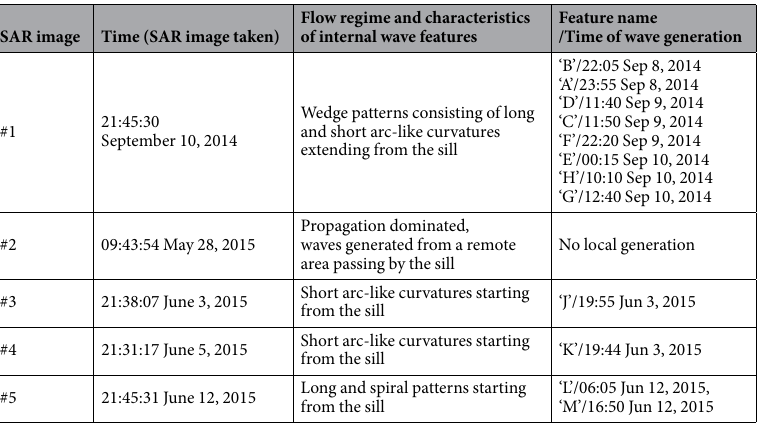
Table 1. Times of SAR observations, flow regimes, characteristics and names of surface frontal feature of waves, and estimated times of wave